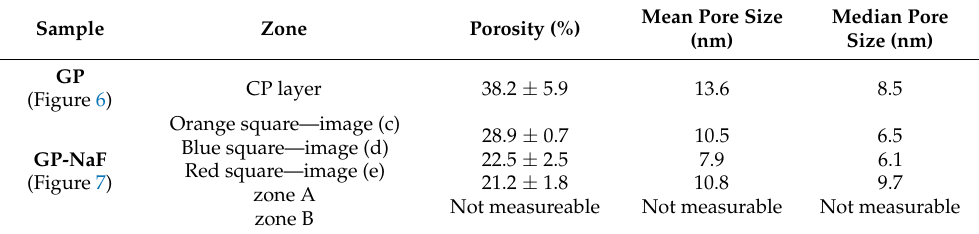
Figure 10. Histograms of the disk size distributions of GP ‐ NaF for ( a ) image (c), ( b ) image (d), and ( c ) image (e) from Figure 7. Table 3. Porosity, mean, and median pore size in CP layers of samples obtained by STEM images analysis using the Fiji software.